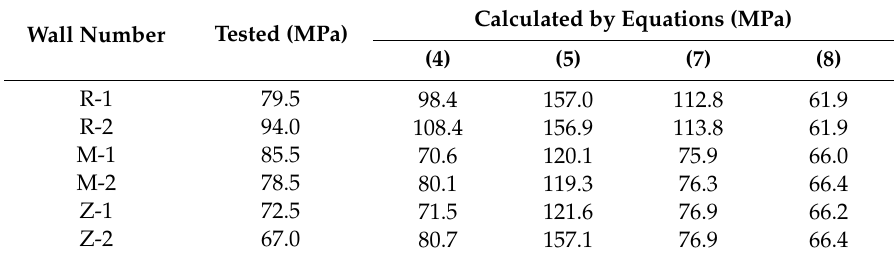
Table 4. Comparison between tested and calculated results of shear resistance of the